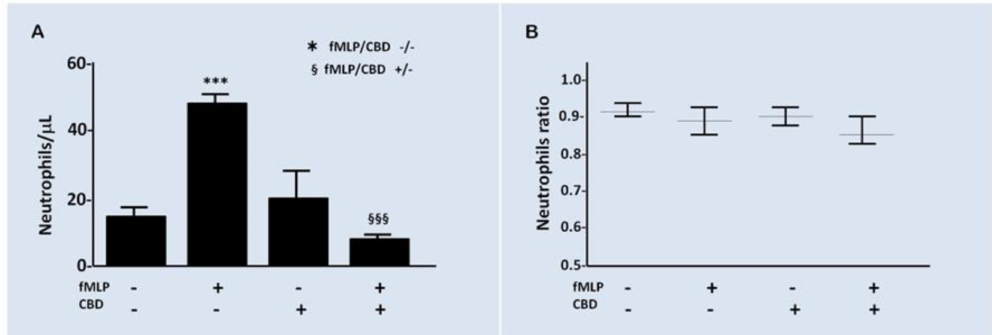
Figure 4. CBD modifies the PMN chemotaxis. ( A ) The activation of chemotaxis by fMLP is signifi- cantly inhibited by CBD ( p < 0.01). *** compared to fMLP/CBD -/- while §§§ compared to fMLP/CBD +/-. ( B ) During the time of the experiment, no differences were observed in the ratio PMN/MN, indicating that chemotaxis results were independent of morphologic modifications. Results are expressed as mean ± SD ( p =